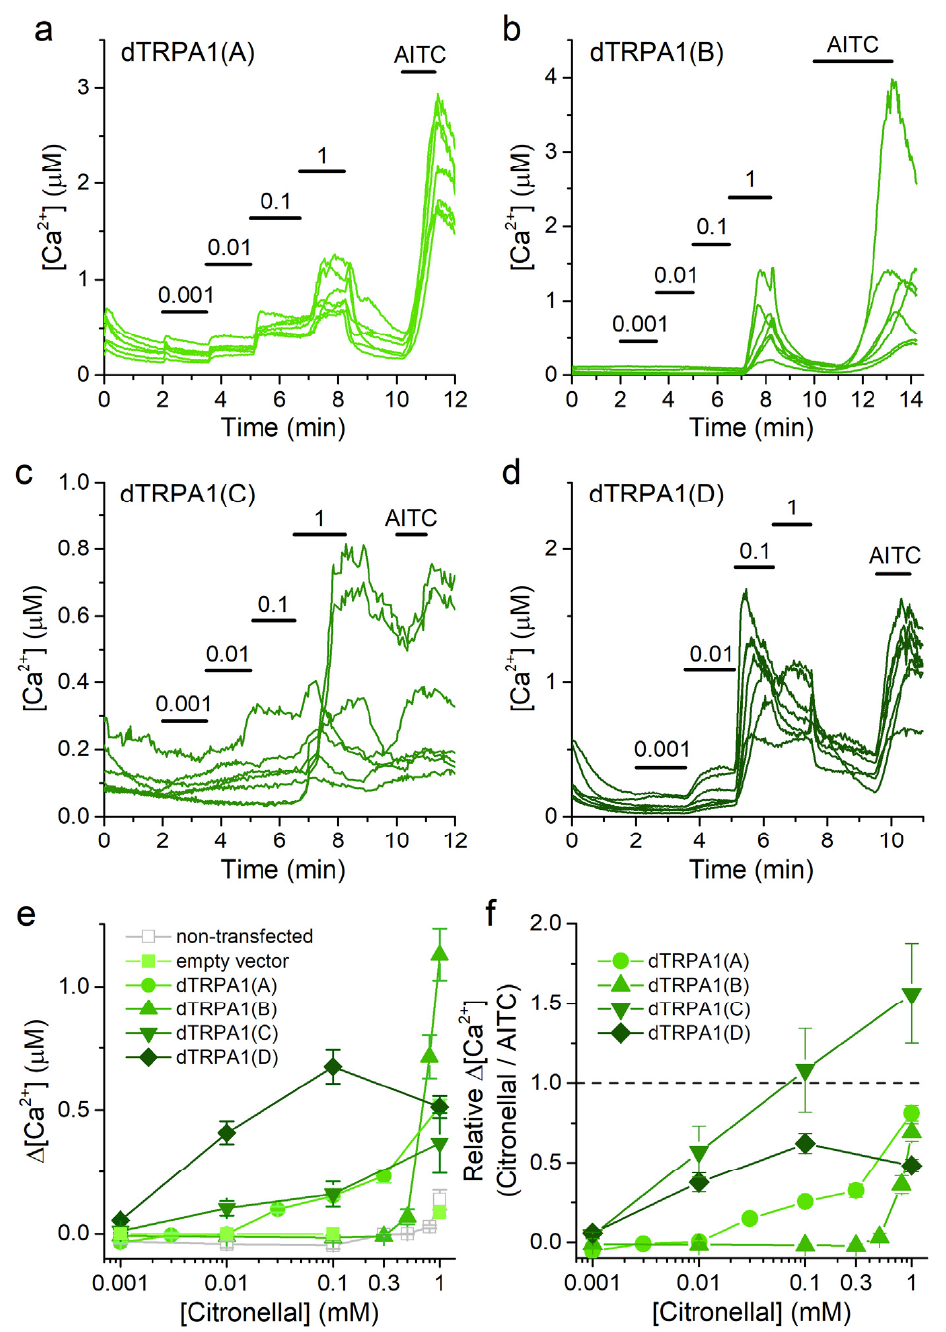
Figure 3. Citronellal increases intracellular [Ca 2+ ] in cells transfected with dTRPA1 isoforms. ( a - d ) Example traces of changes of intracellular Ca 2+ concentration induced by citronellal (0.001-1 mM) and AITC (100 µM) in HEK293T cells expressing either dTRPA1(A), dTRPA1(B), dTRPA1(C) or dTRPA1(D). ( e , f ) Concentration dependence of the average amplitude of intracellular Ca 2+ increase induced by citronellal; panel ( e ) raw data and panel ( f ) data obtained by normalizing to the amplitude of the response to AITC in each cell. n = 102-298, 21-75, 30 and 39 for isoforms A to D, respectively.